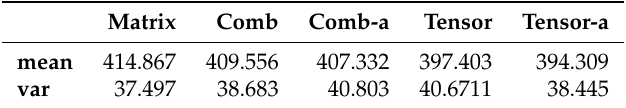
Table 11. Flops for each method (Source: Authors).